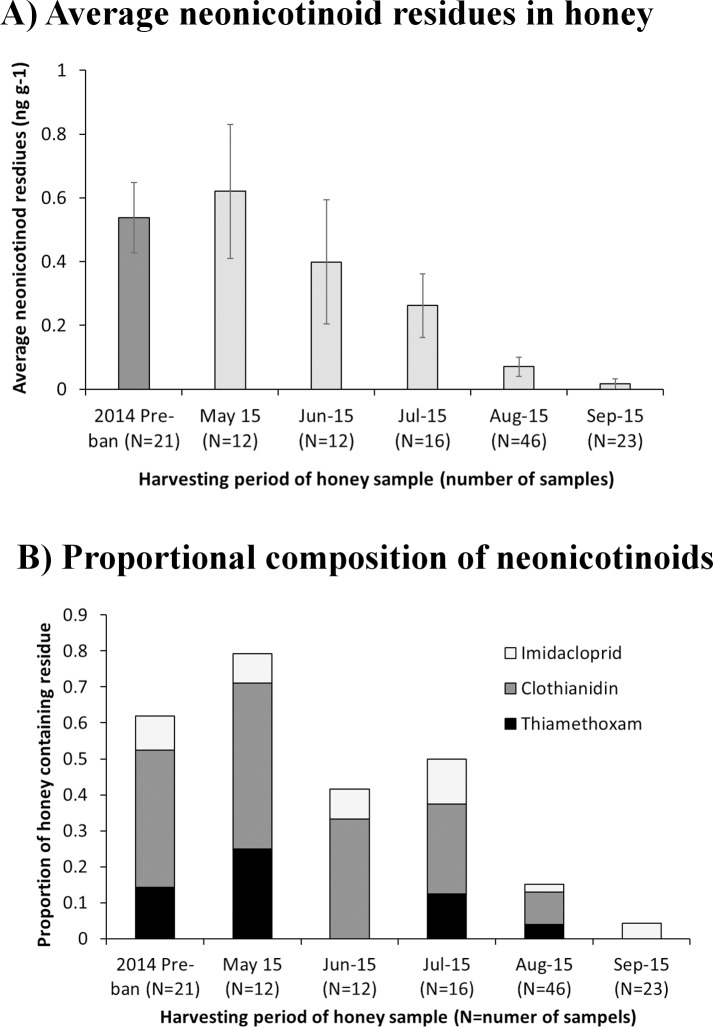
Change in neonicotinoid residues in honey pre- and post-moratorium.The first graph (A) shows the change in average (±SE) combined (clothianidin, thiamethoxam and imidacloprid) residues found in honey over time. Due to the limited number of samples the pre-moratorium period is combined into a single value. The second graph (B) shows how the proportion of honey samples containing neonicotinoid residues changed over time. Note that residues of more than one neonicotinoid type may appear in a single honey sample. As such the proportion of samples containing either clothianidin, thiamethoxam or imidacloprid has been scaled so that when combined it does not exceed the proportion of honey samples containing neonicotinoid residues of any type. Where N = the number of honey samples for a particular time period.